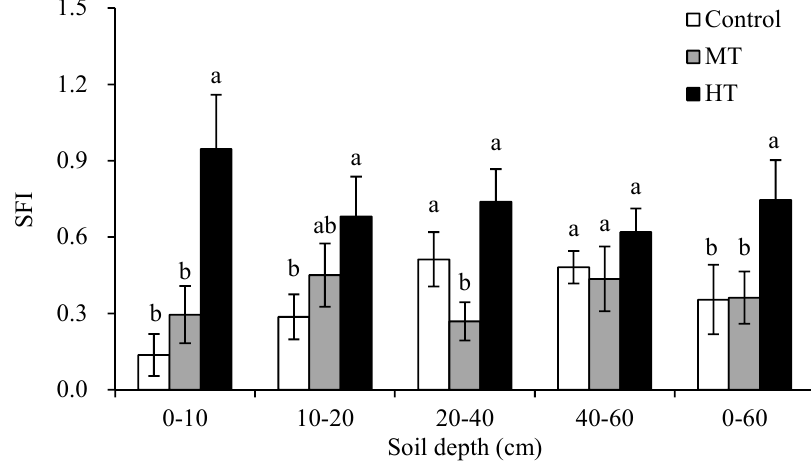
Figure 3. Soil fertility index (SFI) in the three treatments, at different soil depths and in the whole soil profile; Different letters denote a significant difference between treatments ( p < 0.05); Control—traditional management model, MT—moderate thinning, and HT—heavy thinning, mean ± SD.